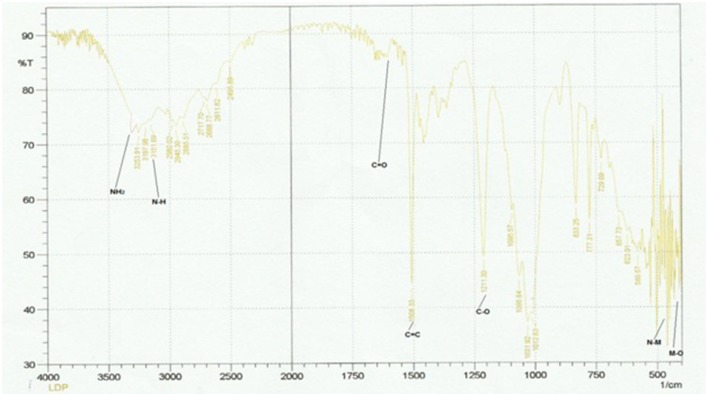
IR spectrum of diphenyltin complex.